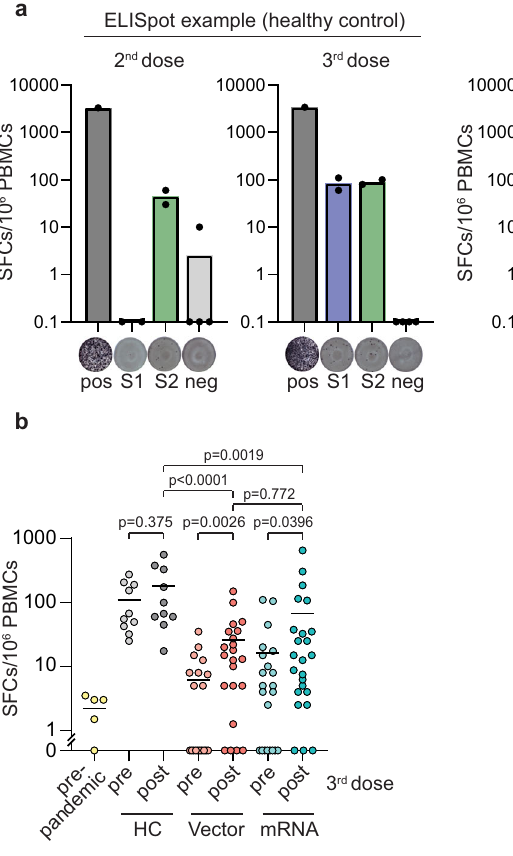
Fig. 3 | SARS-CoV-2-speci fi c T-cell responses. a Representative ex vivo IFN- γ ELI- Spot result from peripheral blood mononuclear cells (PBMCs) stimulated or not (neg, n =4)withphytohemagglutinin(PHA, n =1)orspikesubunitS1andS2peptide pools (S1, S2, n =2 for each) shown for one healthy control (HC) and one patient before and after booster vaccination. Bar graphs show mean spot-forming cells (SFCs) per 10 6 PBMCs. Dots represent individual replicates. b Composite ELISpot results from prepandemic controls ( n =5), vaccinated HC ( n =10), and patients